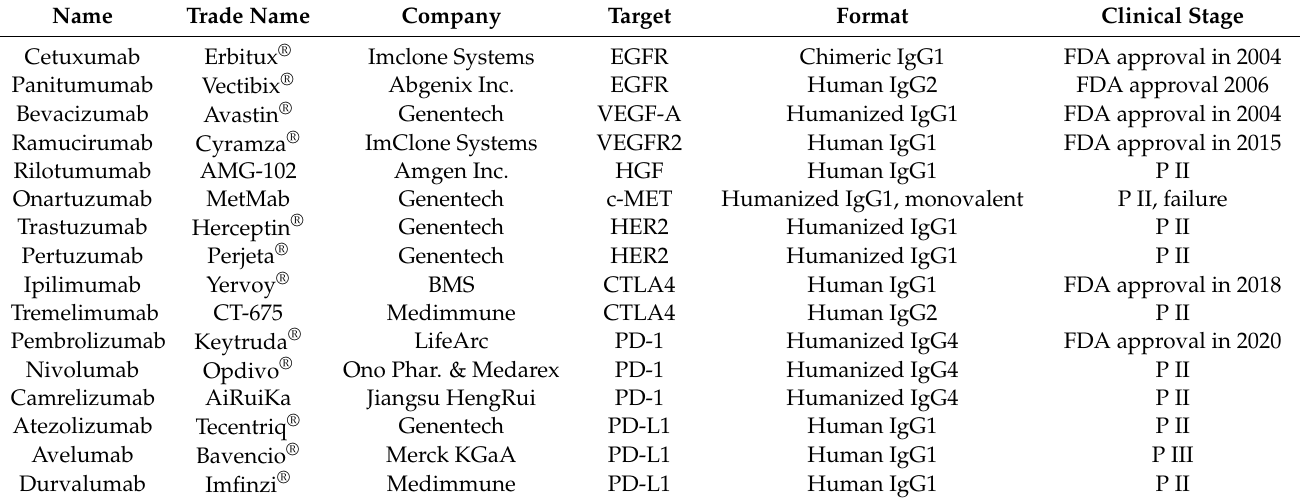
Table 1. Antibody therapeutics currently in clinical trials or approved by the US